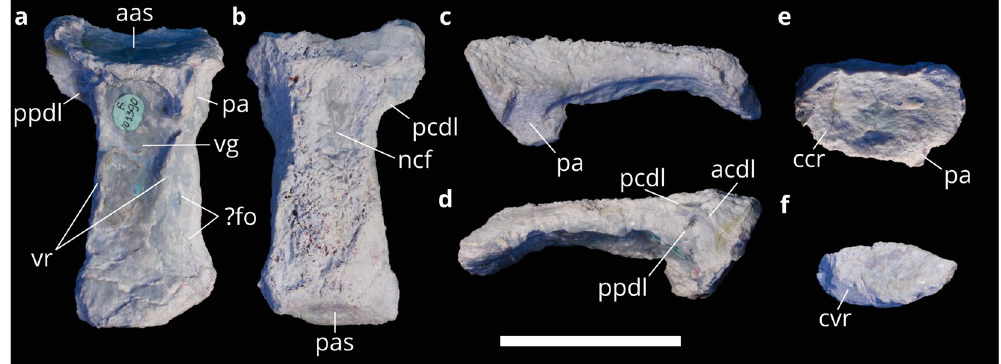
Figure 2. The cervical vertebra LRF 3050.AR in ( a ) ventral; ( b ) dorsal, ( c ) left lateral, ( d ) right lateral, ( e ) anterior and ( f ) posterior views. Abbreviations: aas, anterior articular surface; acdl, anterior centrodiapophyseal lamina; ccr, concave rim; cvr, convex rim; fo, foramina; ncf, floor of the neural canal; pa, parapophysis; pas, posterior articular surface; pcdl, posterior centrodiapophyseal lamina; ppdl, paradiapophyseal lamina, vg, ventral depression; vr, ventrolateral ridge. Scale bar equals 50